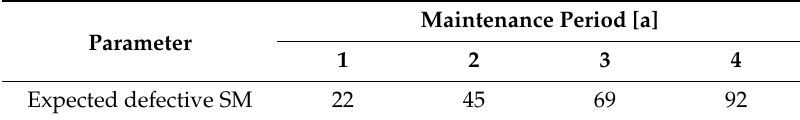
Table 6. Expected number of defective SMs using the probability function for di ff erent maintenance periods.